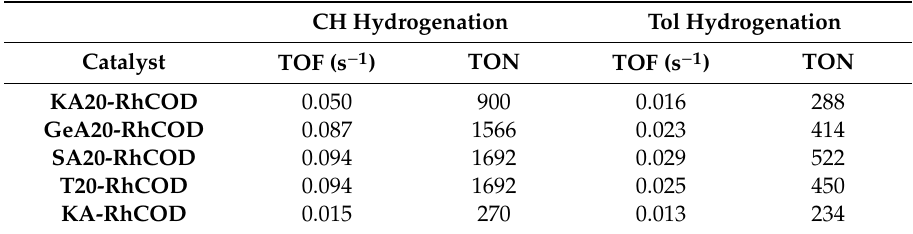
Table 3. TOF (turn over frequency) and TON (turnover number) values in the hydrogenation of cyclohexene and toluene (5% vol CH in toluene, 333 K, 10 bar H 2 ), determined after 5 h of